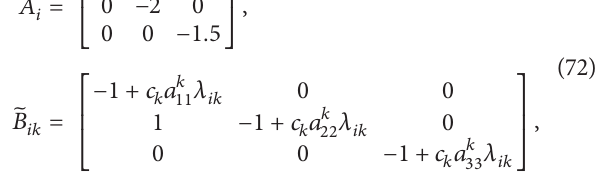
𝑖 = 1, 2, . . . , 5 with 𝑐 the initial